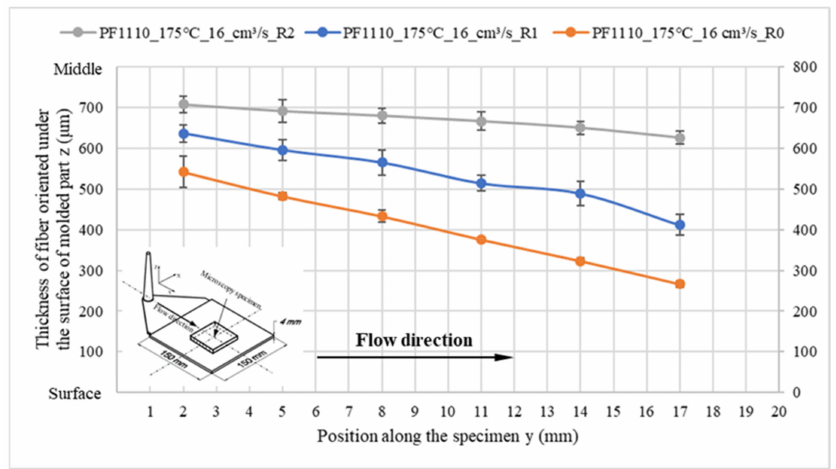
Figure 15. PF1110 (GF35+GB45); the influence of surface roughness on the thickness of fiber orienta- tion under the surface of molded part.